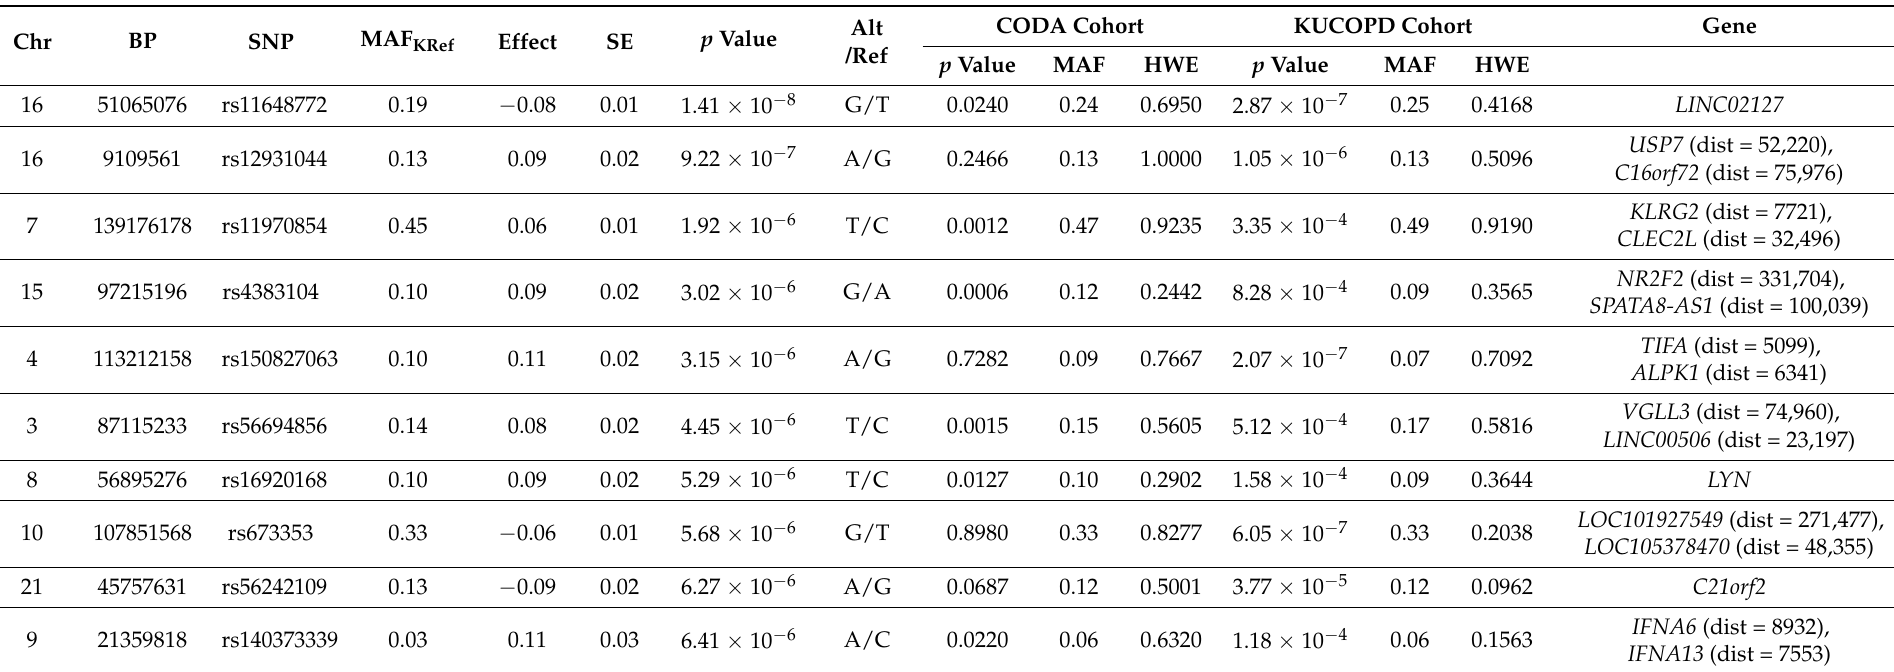
Table 2. Meta-analysis